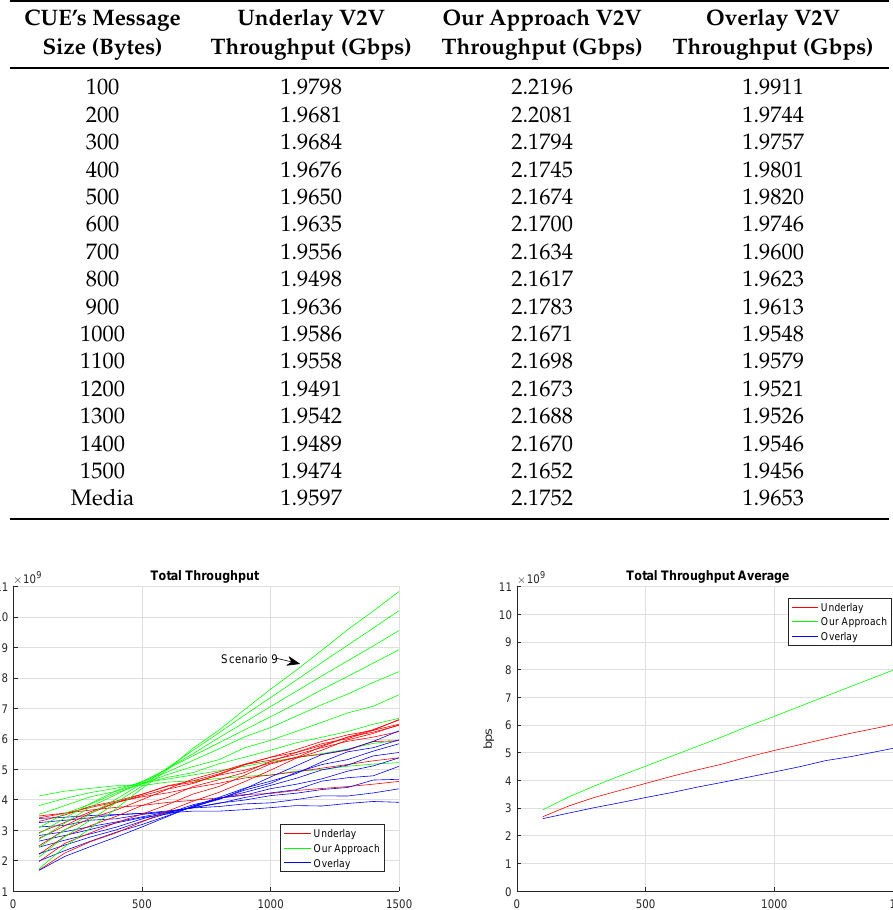
Table 3. Average Throughput offered to V-UEs based on C-UEs’ traffic pattern.